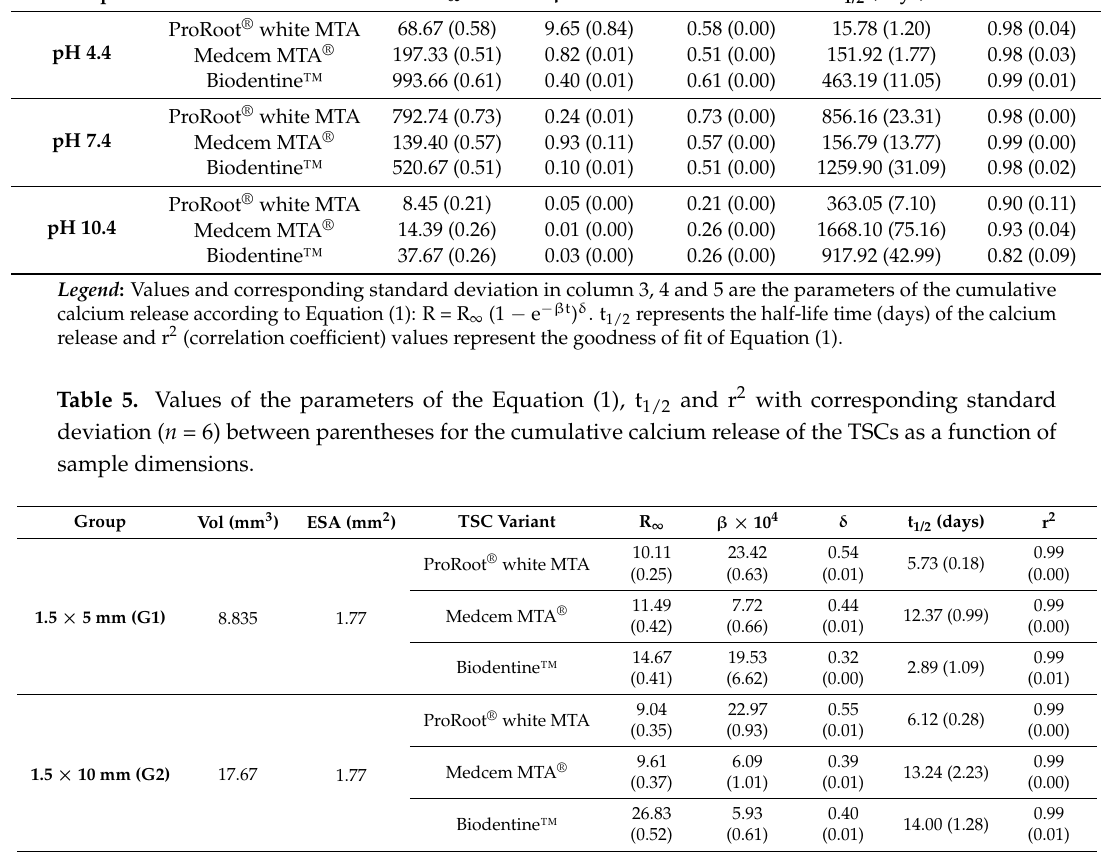
Table 4. Values of the parameters of Equation (1), t 1/2 and r 2 with corresponding standard deviation ( n = 6) between parentheses for the cumulative calcium release of the TSCs as a function of pH. Group